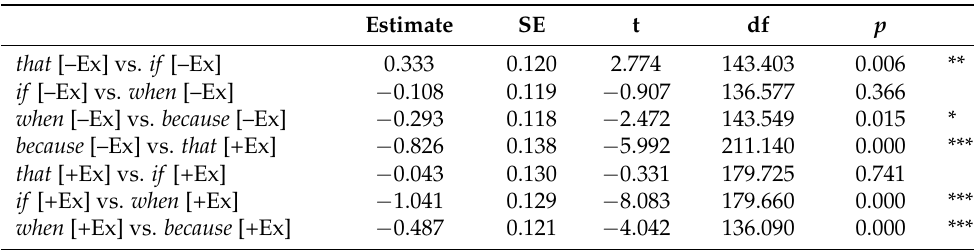
Table 3. Summary of the mixed effects model for the raw ratings of the target sentences (adjunct